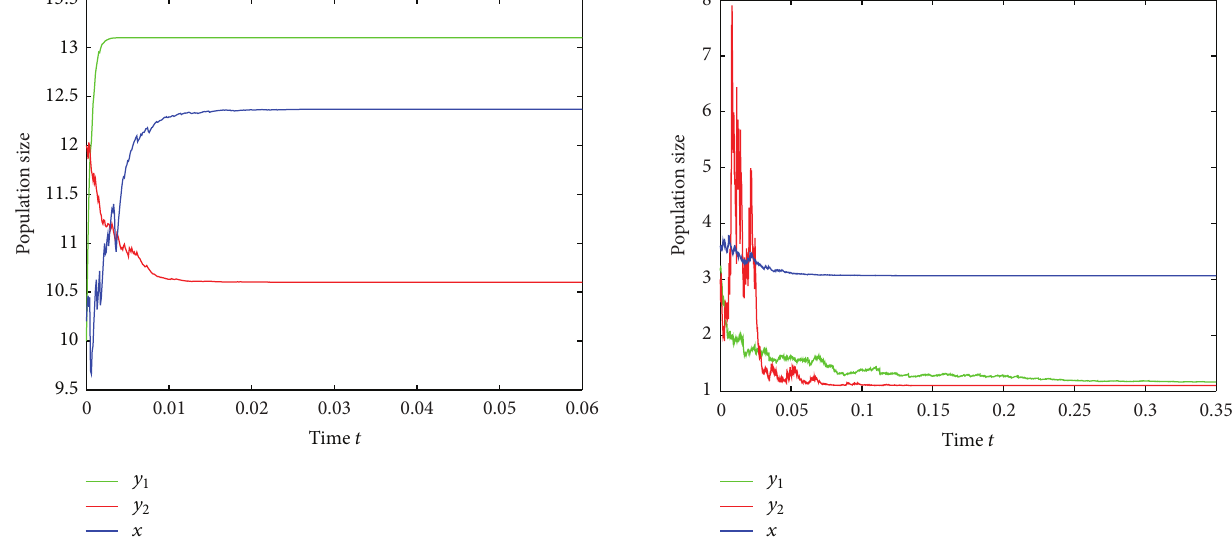
Figure 2: The solution of the stochastic model (4) with the same parameters as in Figure 1.